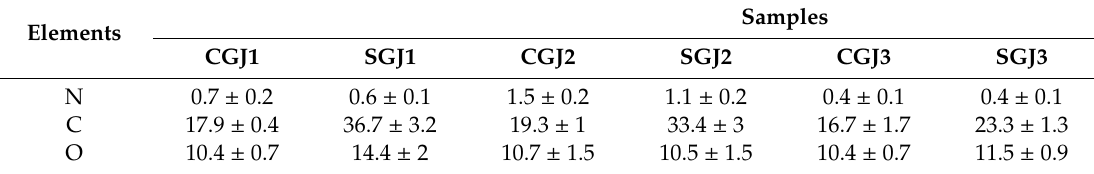
Table 5. Wavelength dispersive spectroscopy (WDS) measurements of the compositions in wt% of CGJ1 (crude glucans from jujubes of first harvesting); CGJ2 (crude glucans from jujubes of second harvesting); CGJ3 (crude glucans of jujubes at third harvesting); SGJ1 (soluble glucans from jujubes of first harvesting); SGJ2 (soluble glucans from jujubes of second harvesting); SGJ3 (soluble glucans from jujubes of third harvesting).